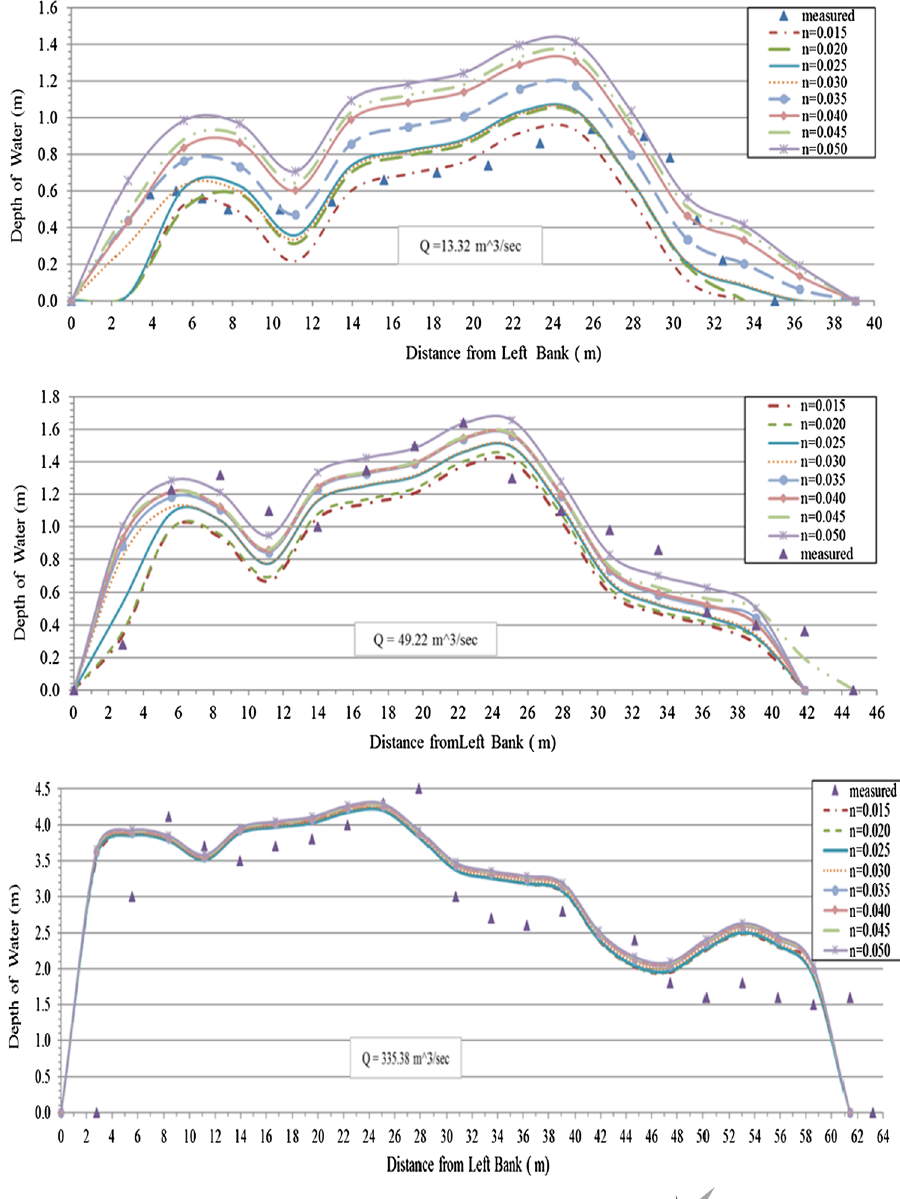
Fig. 4 Water depth profiles at cross section of Shahmokhtar station for different Manning’s roughness